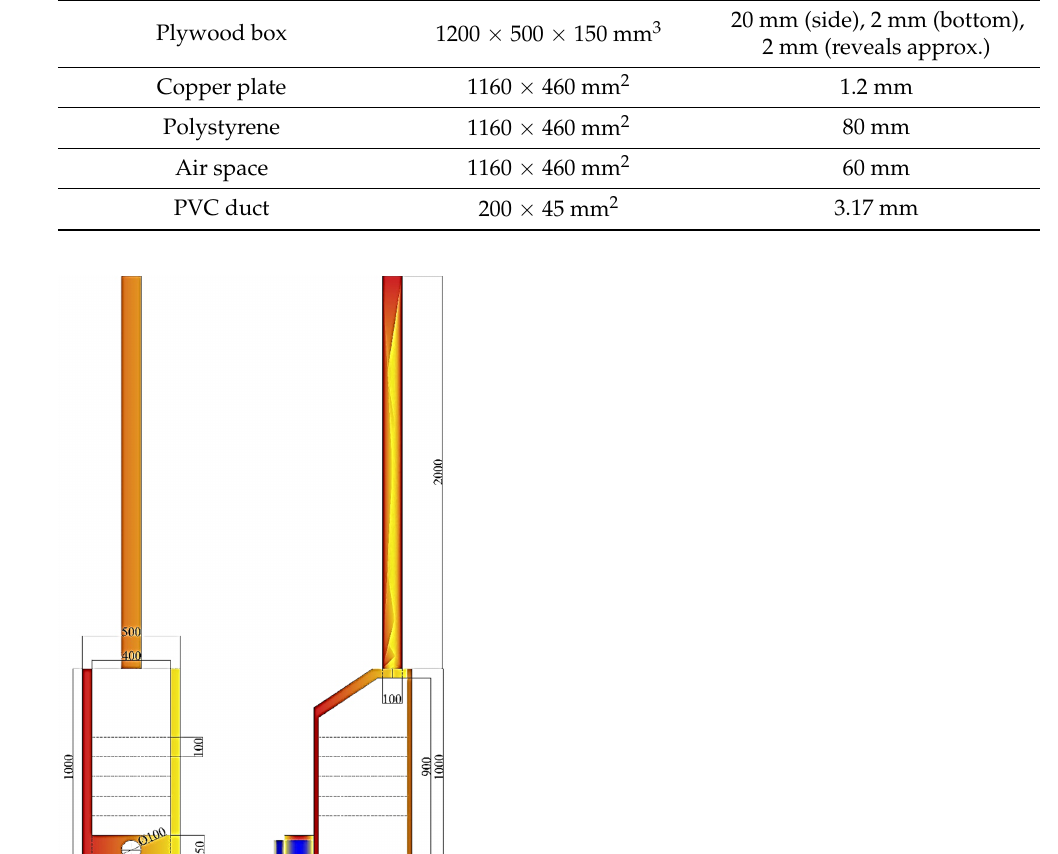
Table 2. Geometrical details of material used for construction of solar collector.